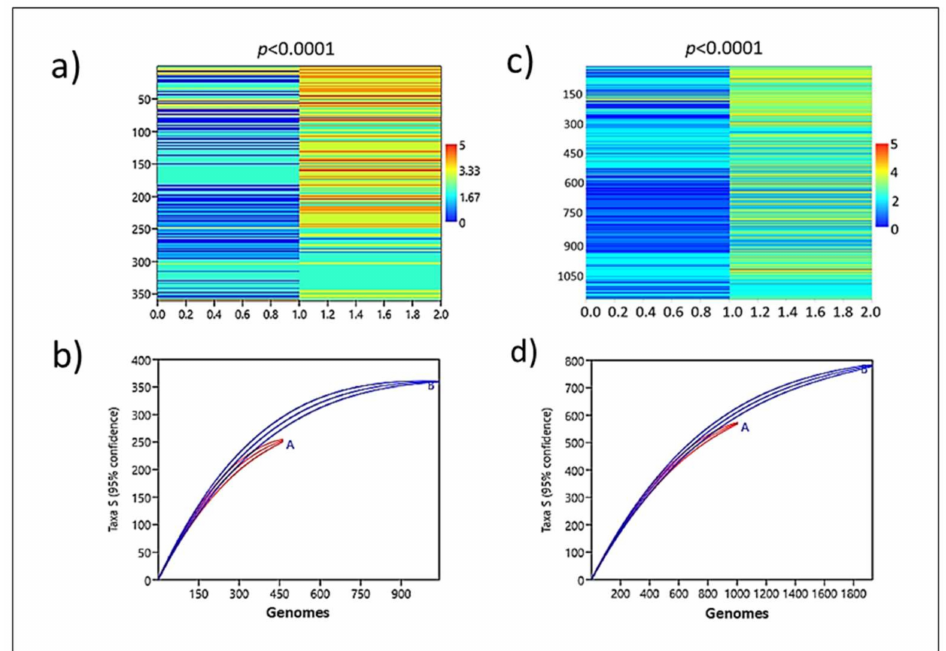
Figure 6. Interpolated plot from the transition matrix, showing the enrichment of antimicrobial resistance genes among ardA -H positive ( − ) in comparison with ardA -H negative ( − ) genomes. ( a ) A total of 720 genomes were analyzed with the following distribution: ardA -H ( − ) ( n = 360) and ardA -H (+) (allele-1 ( n = 360)). ( b ) A total of 1564 genomes were analyzed with the following distribution: ardA -H ( − ) ( n = 782) and ardA -H2 (+) ( n = 782). Color scale: 0 = susceptibility to all antimicrobial drugs, except β -lactams; 1 = resistance to one; 2 = two; 4 = four; and 5 = five or more antimicrobial classes. ( c , d ): Individual rarefaction, showing the distribution of resistance traits in S. aureus genomes with 95% confidence intervals. ( c ) Population A (red plot) is formed by genomes lacking ardA -H ( n = 360) and population B (blue plot) is formed by genomes carrying ardA -H (+) (allele-1( n = 360)). ( d ) Population A (red plot) is formed by genomes lacking ardA -H ( n = 782), and population B (blue plot) is formed by genomes carrying ardA -H2 ( n = 782).